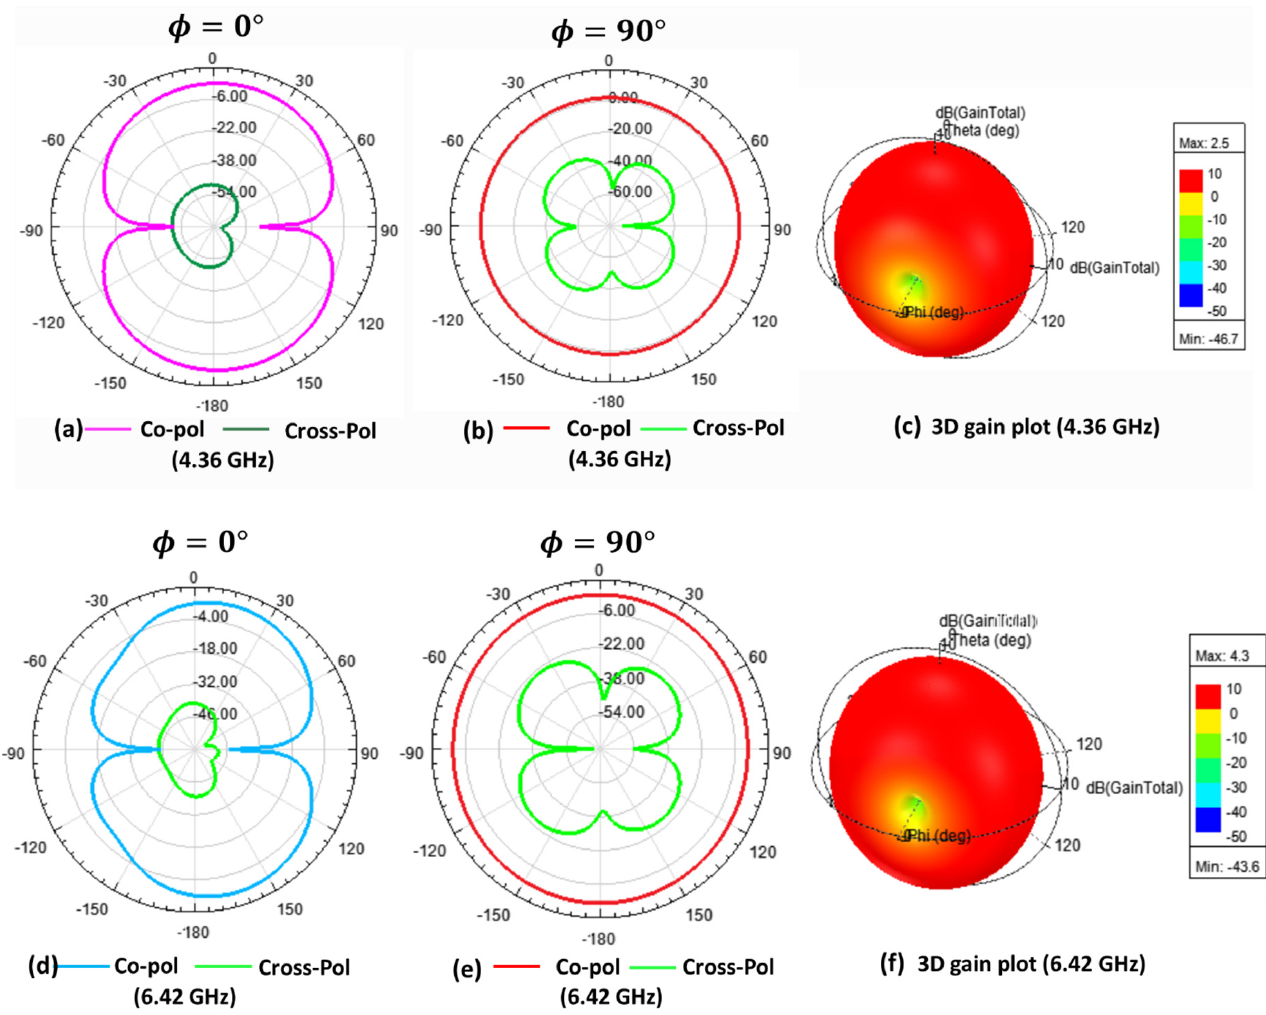
Figure 10. The simulated co- and cross-polarization and 3D gain plot: ( a ) The x-z plane; ( b ) The y-z plane; ( c ) The 3D gain plot, at 4.36 GHz; ( d ) The x-z plane; ( e ) The y-z plane; and ( f ) The 3D gain plot, at 6.42 GHz.